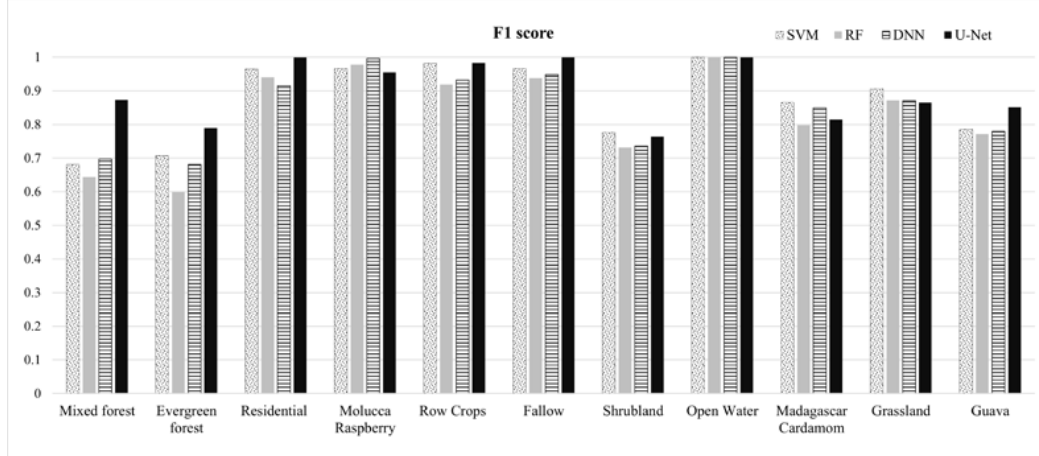
Figure 5. F1 score (Equation (6)), for all classes and models, showing the superiority of the FCNN U-Net model. 3.2. SWIR Bands The removal of SWIR bands reduced the accuracy by 5.42%, 3.18%, 8.55%, and 1.87% for the SVM, RF, DNN, and U-Net models, respectively (Table 3). The confusion matrix for the DNN and U-Net models from which accuracy metrics are derived is shown in Figure 6. The DNN model is chosen for comparison because of the greatest percent change due to the removal of SWIR bands, producing the worst accuracy when SWIR bands were removed. The U-Net model is chosen because of the lowest reduction in accuracy when the SWIR bands were removed. The removal of the SWIR bands amplifies the number of misclassified pixels between classes: for example, guava pixels being classified as Madagascar Cardamom (Figure 6). A decrease in the producer’s and user’s accuracy for Madagascar Cardamom and Guava, which are invasive plant species, is seen (Figure 7). Table 3. Overall accuracy (Equation (2)) and percent change for all classification models including (16 bands) and excluding (8 bands) the shortwave infrared (SWIR) bands.